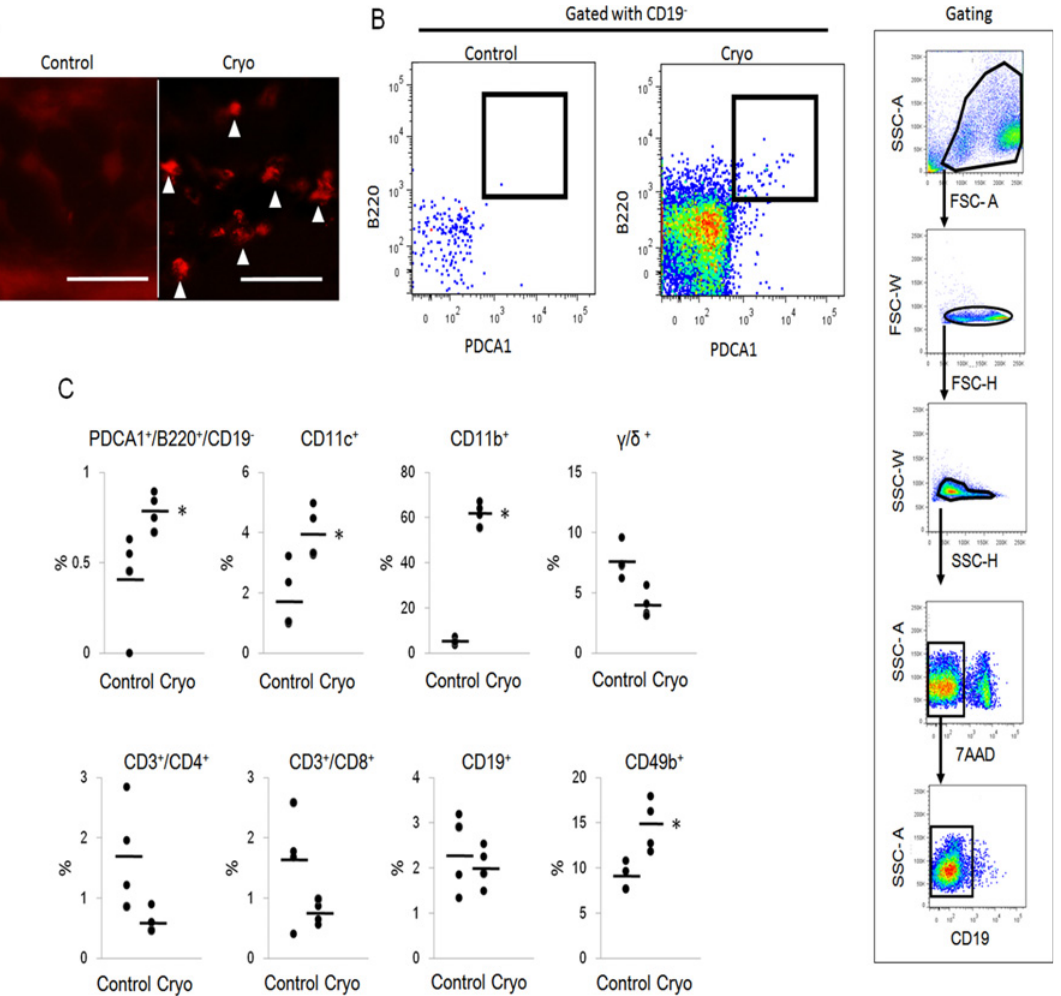
Fig 6. Profile of infiltrating cells. A) Immunohistochemistry of PDCA1. PDCA1 + cells infiltrate in the cryoablated skin ( ▲ , arrowhead). Scale bars, 20 μ m. B) C) Flow cytometry analysis of infiltrating cells. B) Dots within bold square box shows PDCA1 + B220 + CD19 - plasmacytoid dendritic cells. Gating strategy is also shown. Dead cells, which are 7-AAD + , were removed. We used CD11c for mDCs, CD11b for neutrophil and macrophage, TCR γδ for γδ T cells, and CD49b for natural killer cells. Cryo, cryoablation. All data are shown as dots (C). Bars represent the mean values. Significant differences between the means are indicated, * P < 0.05 versus control. n = 4, in each